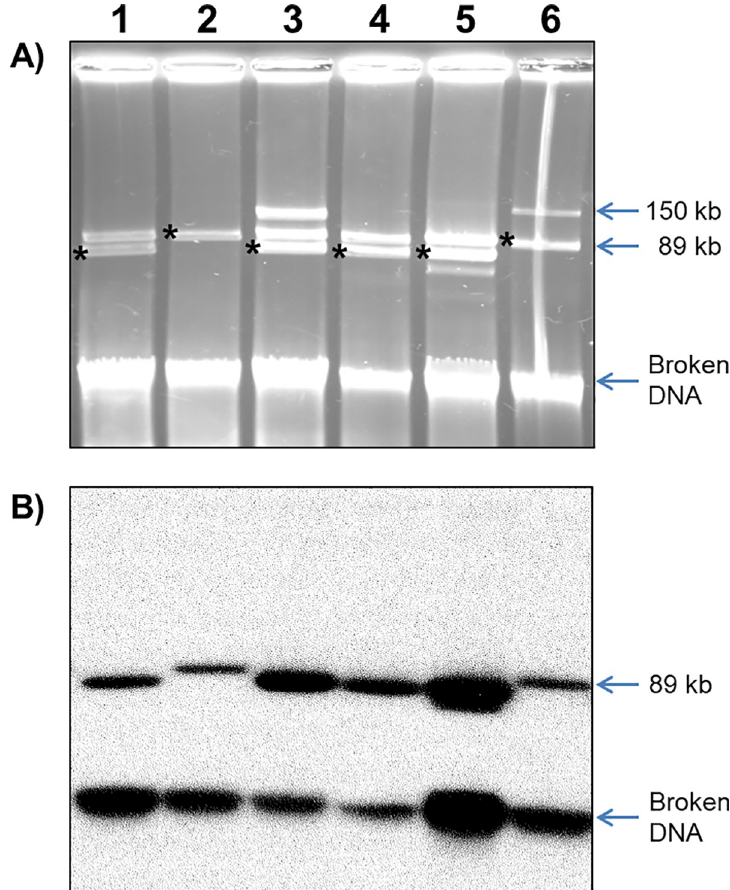
Fig 4. Plasmid profiles and c1 Southern blot hybridization of representative Typhimurium ST213 strains. A) Agarose gel showing the large plasmids for strains SO10, SL30, SO21, SO22, SO23 and YU07-18. The asterisks at the right side of the bands indicate the plasmid hybridizing with the c1 probe. B) Autoradiogram of the c1 Southern blot corresponding to the gel shown in panel A).